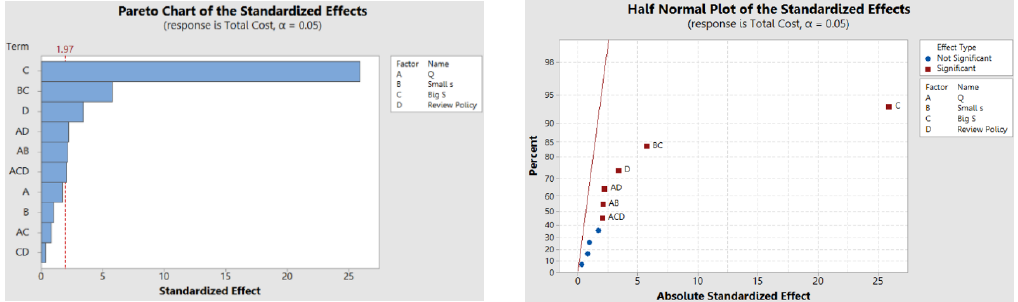
Figure 9. Pareto chart and half-normal plot of the standardized effects.